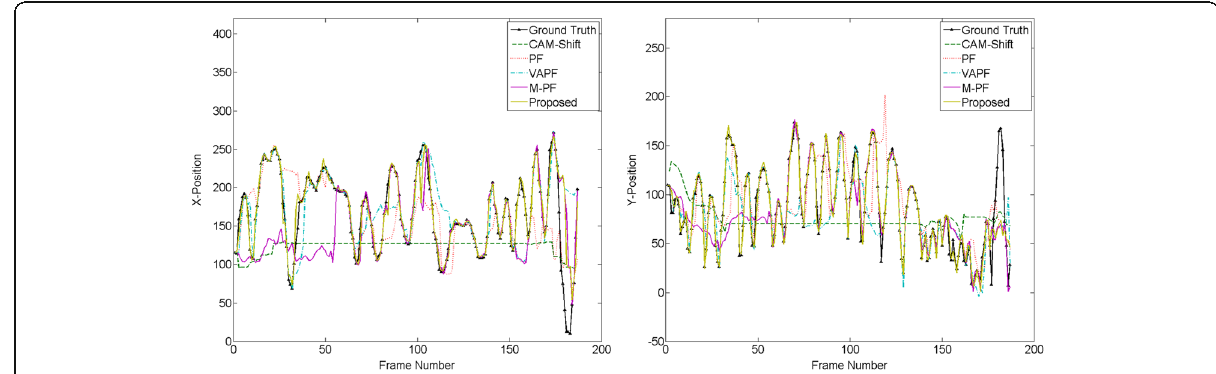
Fig. 22 Estimated object center position of “ basketball_2 ” compared with ground truth with the particle number N =